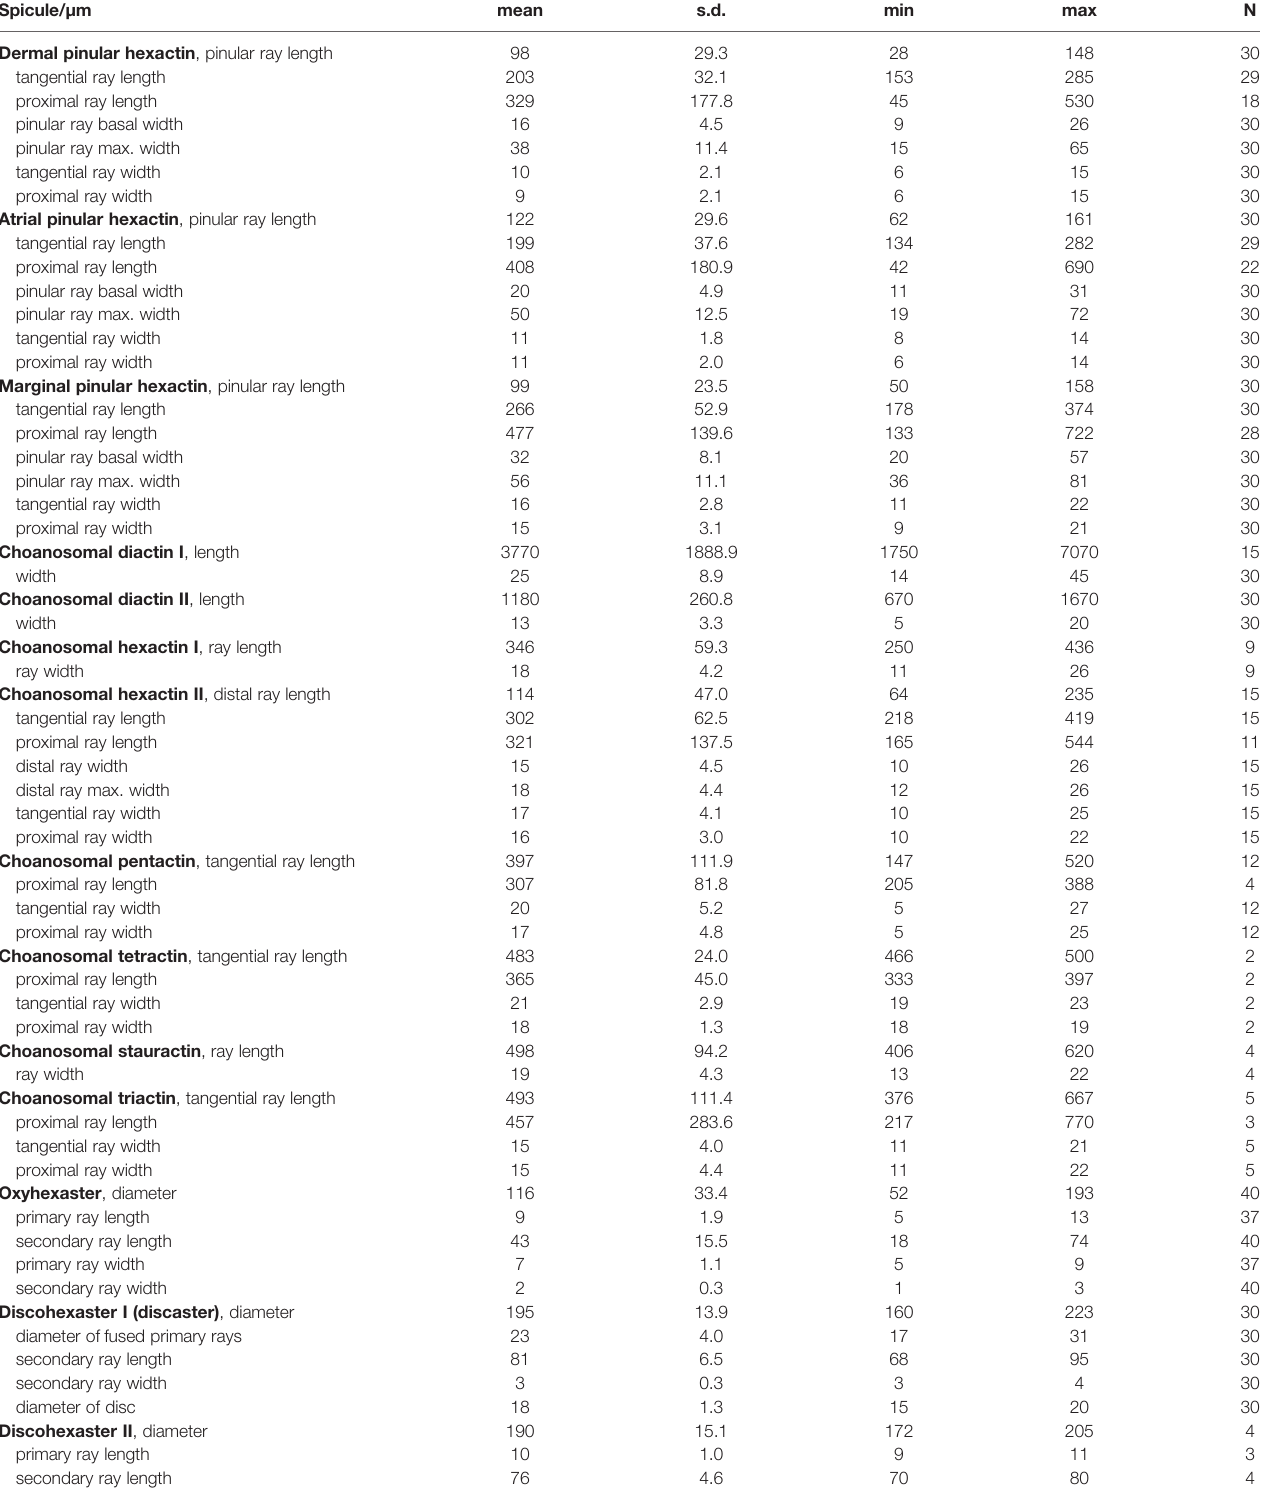
TABLE 1 | Spicule dimensions of Flavovirens hemiglobus gen. et sp. nov., holotype (in µm). Spicule/µm mean s.d. min max N Dermal pinular hexactin , pinular ray